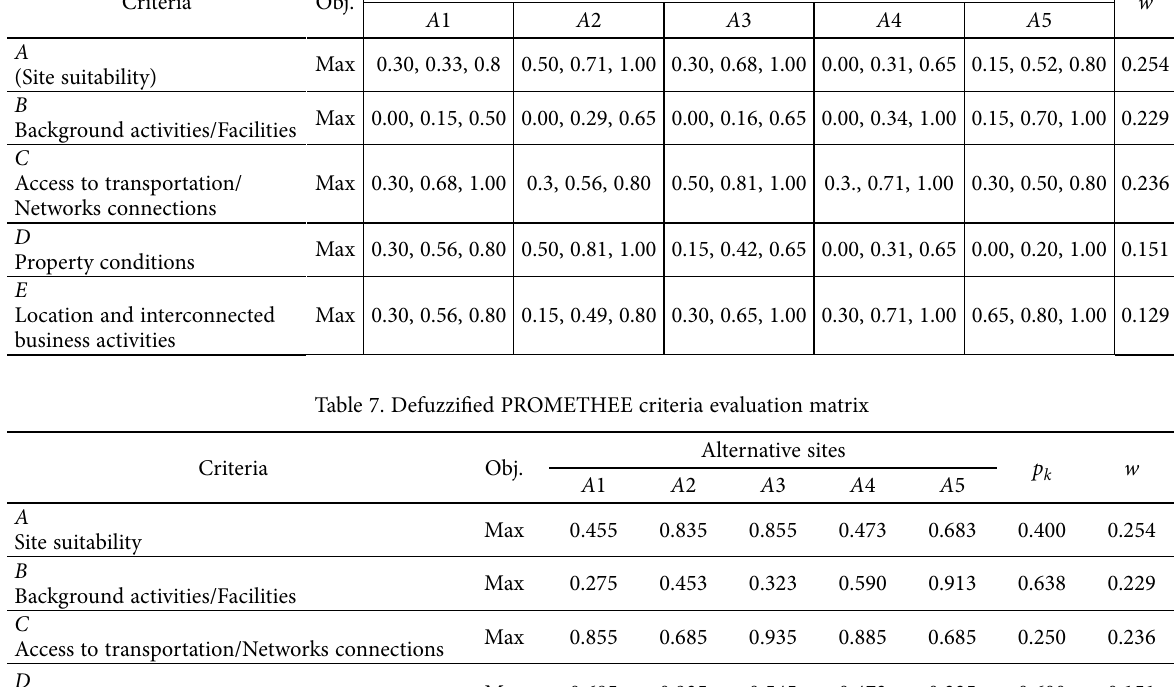
Table 6. F-PROMETHEE criteria evaluation matrix Criteria Obj.